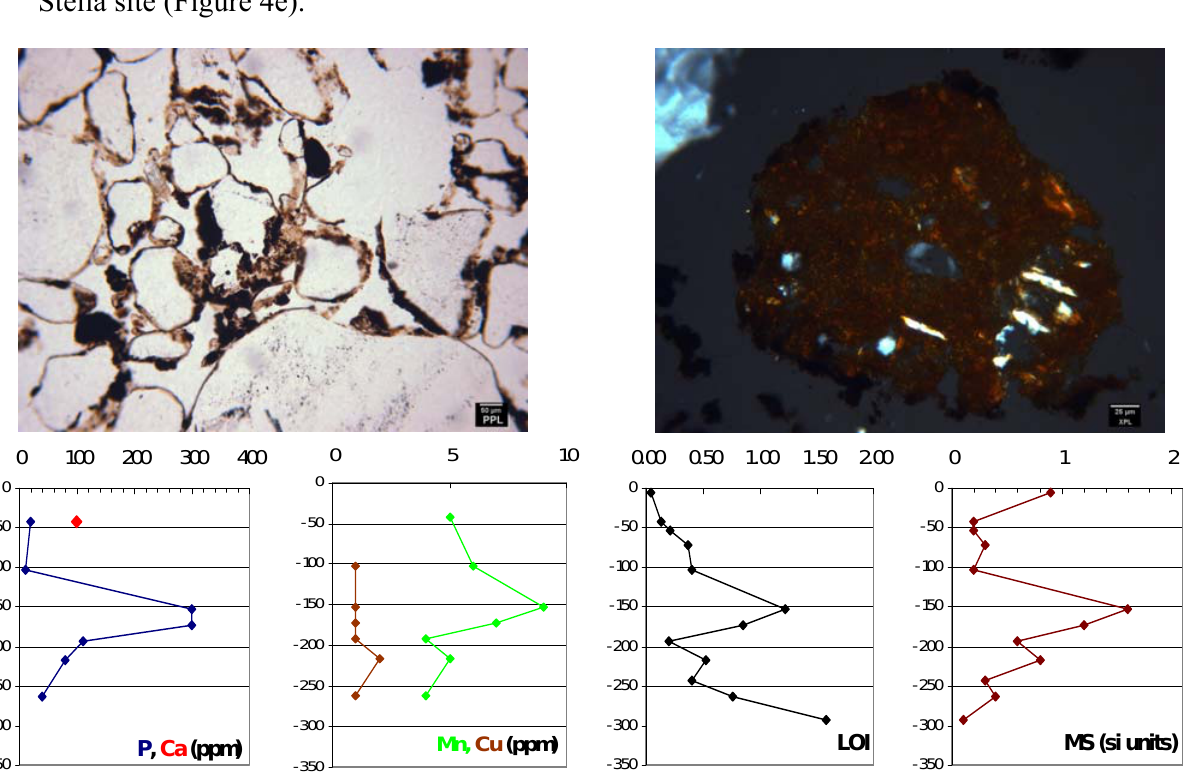
Figure 7. Top: Microphotographs of the buried horizon at the Dona Stella site. Left: charred plant matter embedded in the scant clay adhered to quartz grains composing the skeleton of the sediment. Right: microscopic fragment of burnt clay. The author believes it represents a microscopic fragment of ancient pottery. Very rare pottery shards are recorded at the site (Arroyo-Kalin, personal notes, 2006) but until now have been regarded as intrusive from later occupations. Bottom: total elemental concentrations (measured by ICP- AES), carbon estimates (LOI, 550C), and magnetic susceptibility values (Low frequency Tesla units, measured with a dual frequency Bartington MS2/MS2B sensor) from the Dona Stella site (Figure